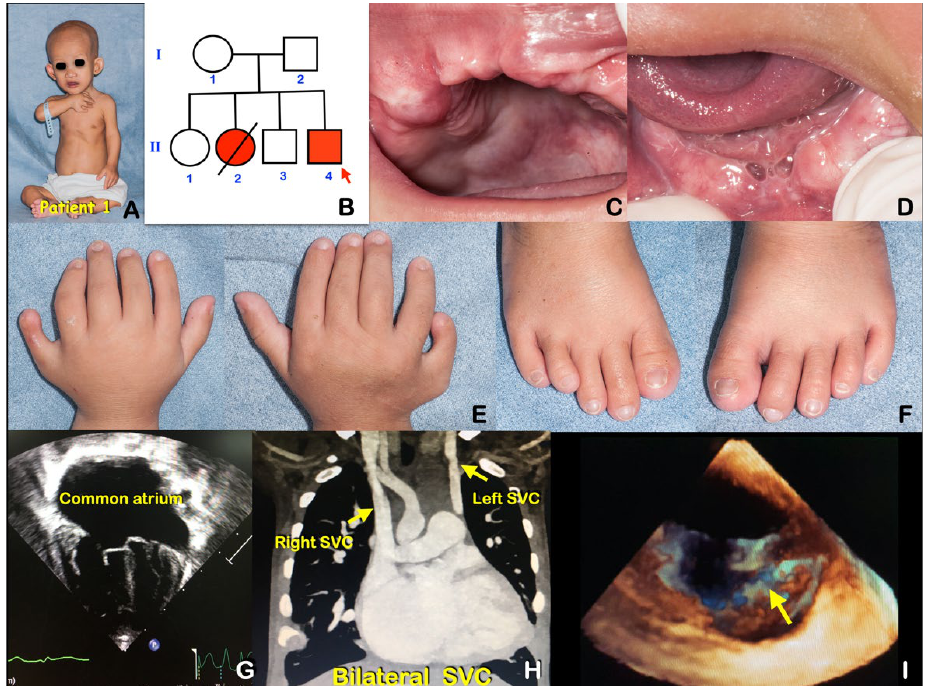
Figure 1. Patient 1 at age 2 years. Ellis–van Creveld syndrome caused by a novel homozygous EVC2 mutation. ( A ) Note hypotrichosis and narrow chest. ( B ) Pedigree shows that case II-2 was affected with Ellis–van Creveld syndrome and died. ( C , D ) Multiple frenula and serrated alveolar ridges. ( E ) Post-axial polydactyly of the hands. Note small fingernails. ( F ) Toenails were small. ( G ) Echocardiogram showed a common atrium. ( H ) Echocardiogram showed bilateral superior vena cava. ( I ) Three-dimensioned echocardiogram showed cleft mitral valve.